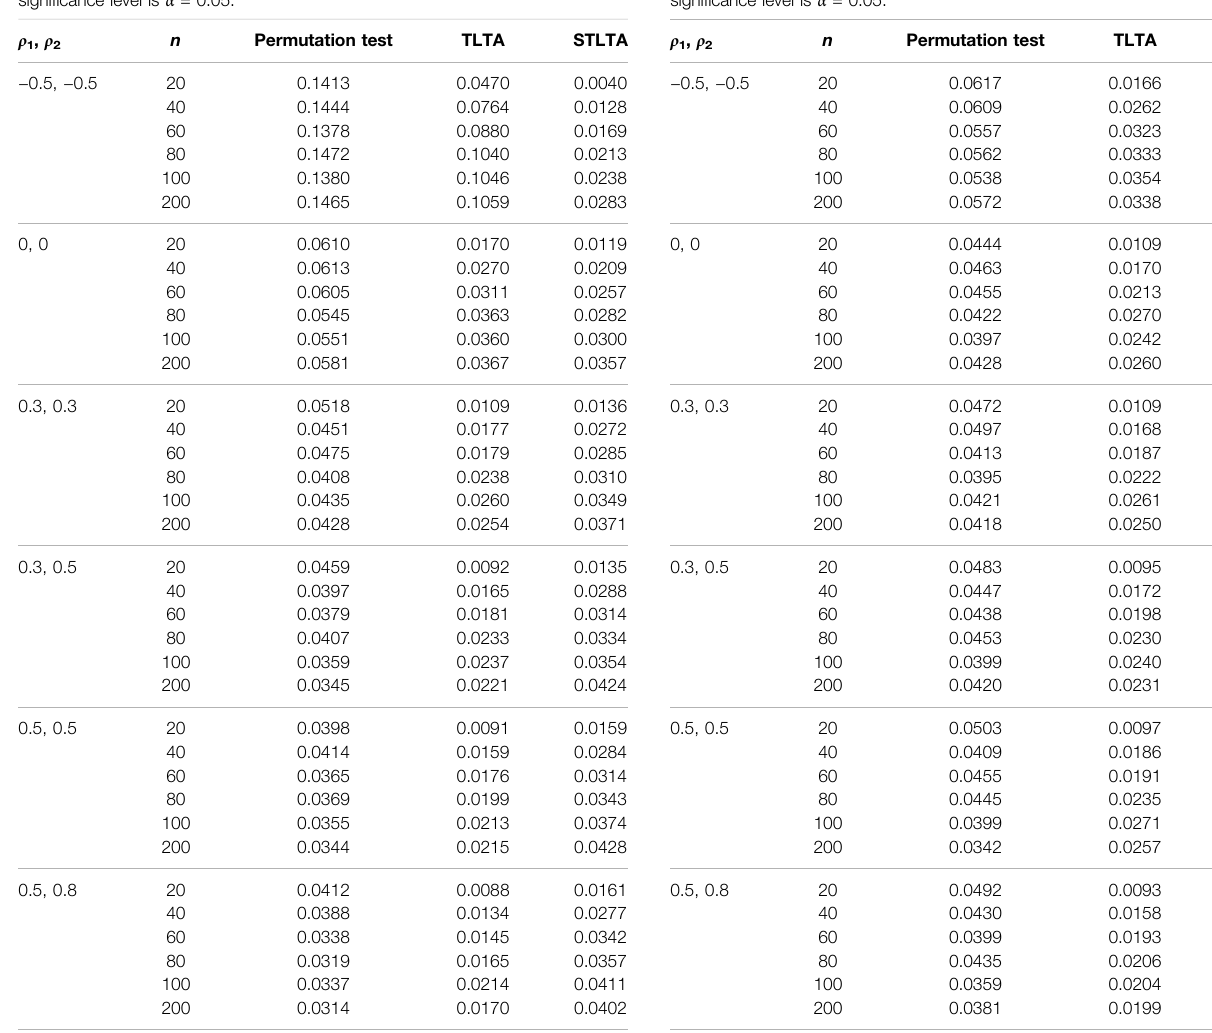
TABLE 1 | Type I error rate for different methods (the third to fi fth columns) in the AR(1) model when t = 0. The fi rst and second columns represent different combinations of autoregressive coef fi cients and sample sizes. The number of permutation tests is 1,000, the number ofrepeated simulations is 10,000, and the signi fi cance level is α = 0.05.